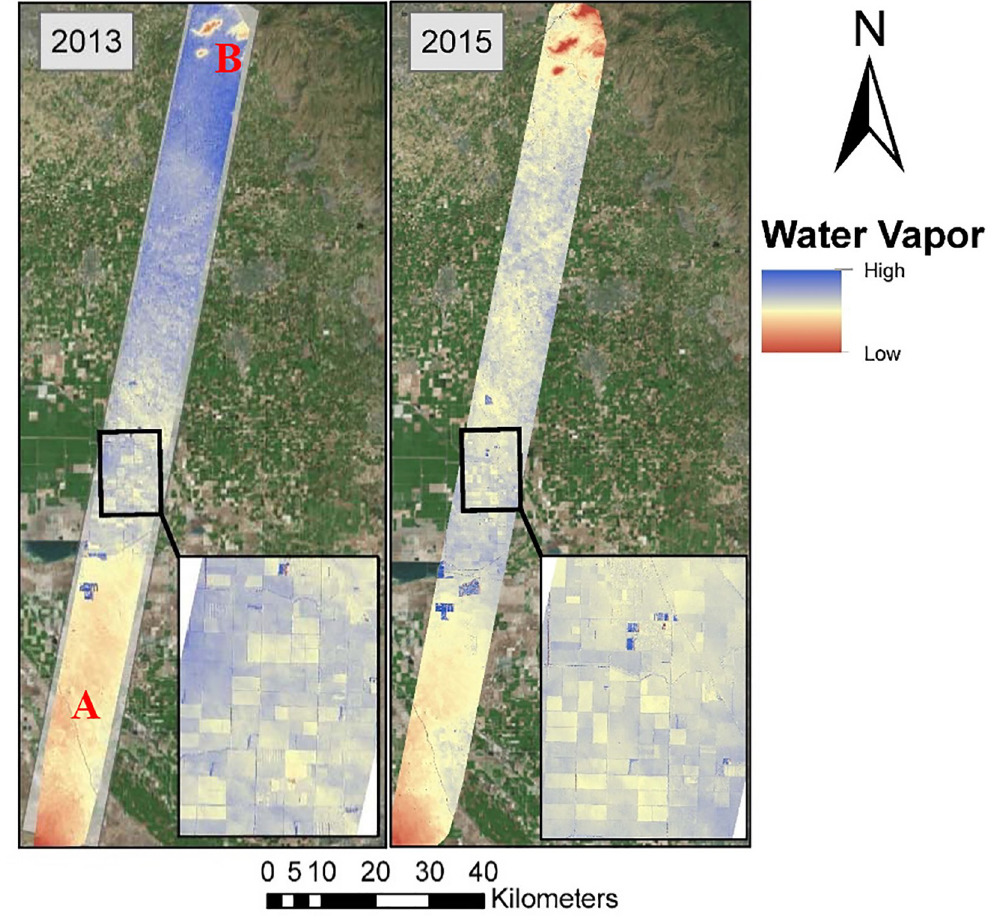
Fig 6. Water vapor images produced using AVIRIS radiance imagery and ACORN reflectance retrieval algorithm. The area between A and B corresponds to the low relief, densely cropped portion of the flight line. Basemap obtained from Esri ArcGIS. Sources: Esri, DigitalGlobe, GeoEye, i-cubed, USDA FSA, USGS, AEX, Getmapping, Aerogrid, IGN, IGP, swisstopo, and the GIS User Community.